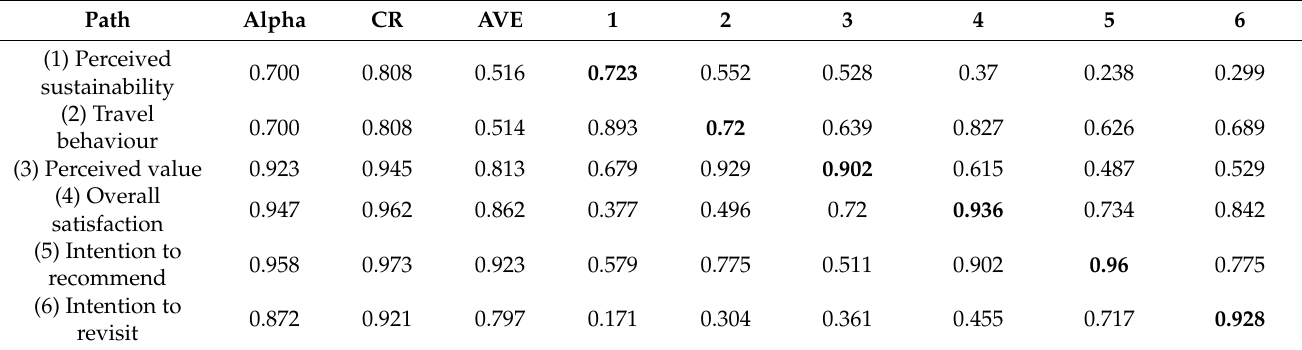
Table 1. Correlations, reliability tests, and HTMT ratios.